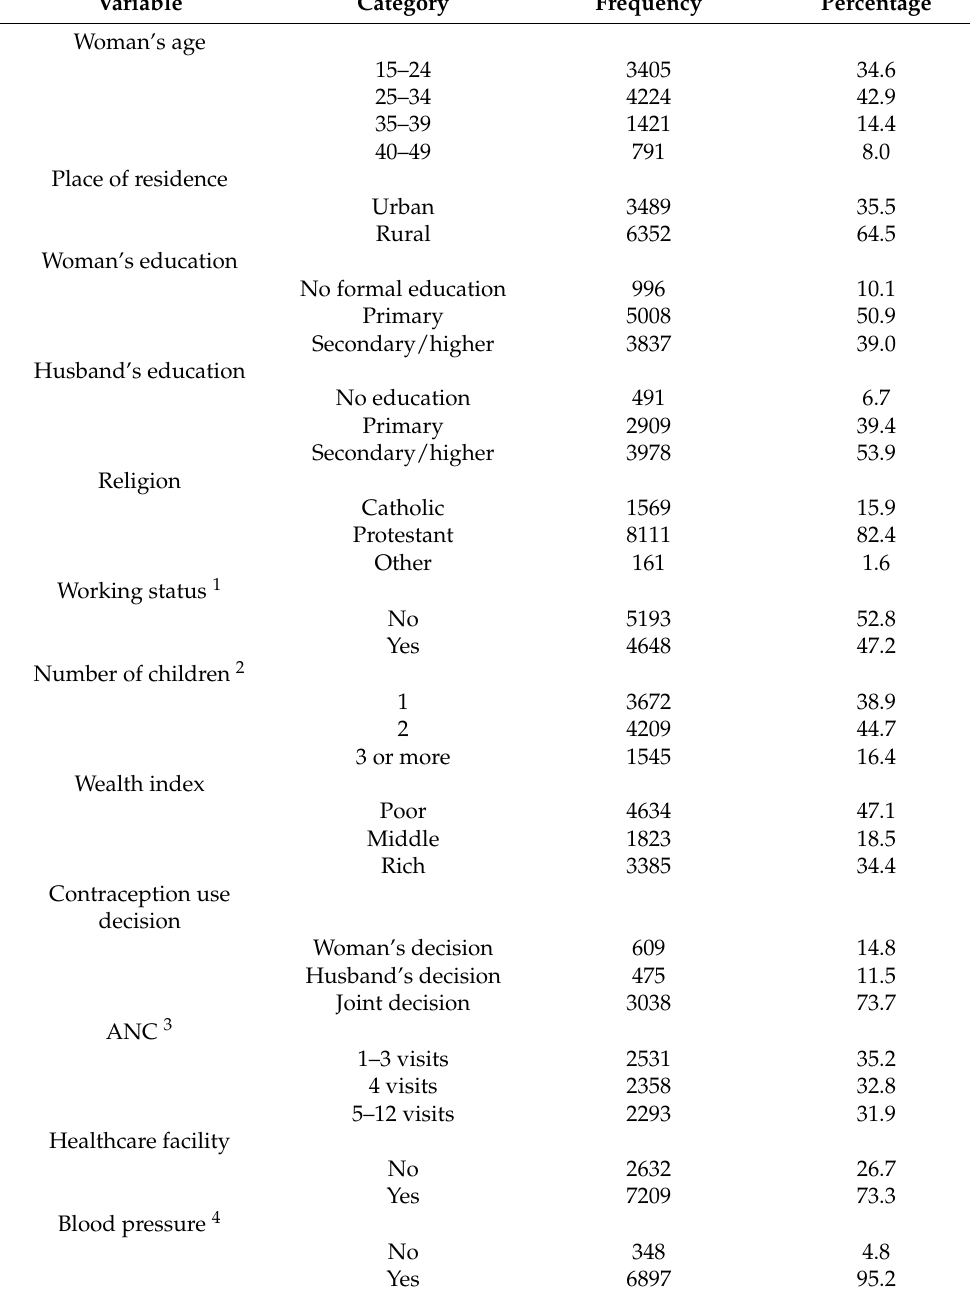
Table 1. Background characteristics of the study population ( n =